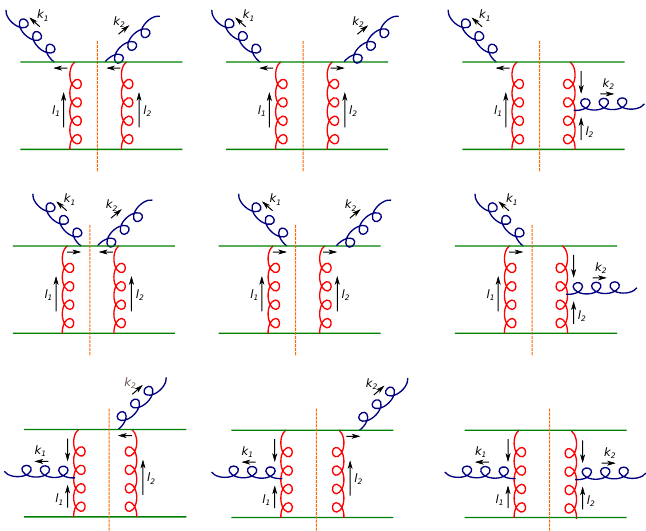
Figure 2 . Diagrams at O ( (cid:11) 3 A 2 3 ). The S (0) propagators, crossed by orange dashed lines, separate s 22 each diagram into two. In A + = 0 gauge, there are three diagrams for the classical (cid:12)eld A a(cid:22) . Each diagram in this (cid:12)gure corresponds to that in the product of two classical (cid:12)elds. In each diagram the quark on the top has a large P + while the one at the bottom has a large P (cid:0)